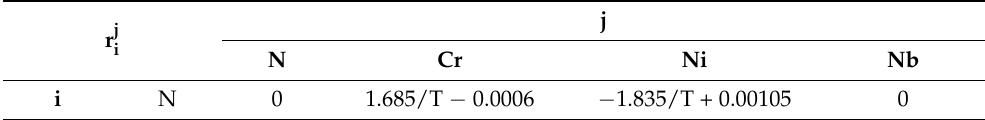
in liquid Fe-Cr-Ni-Nb system. Data from i